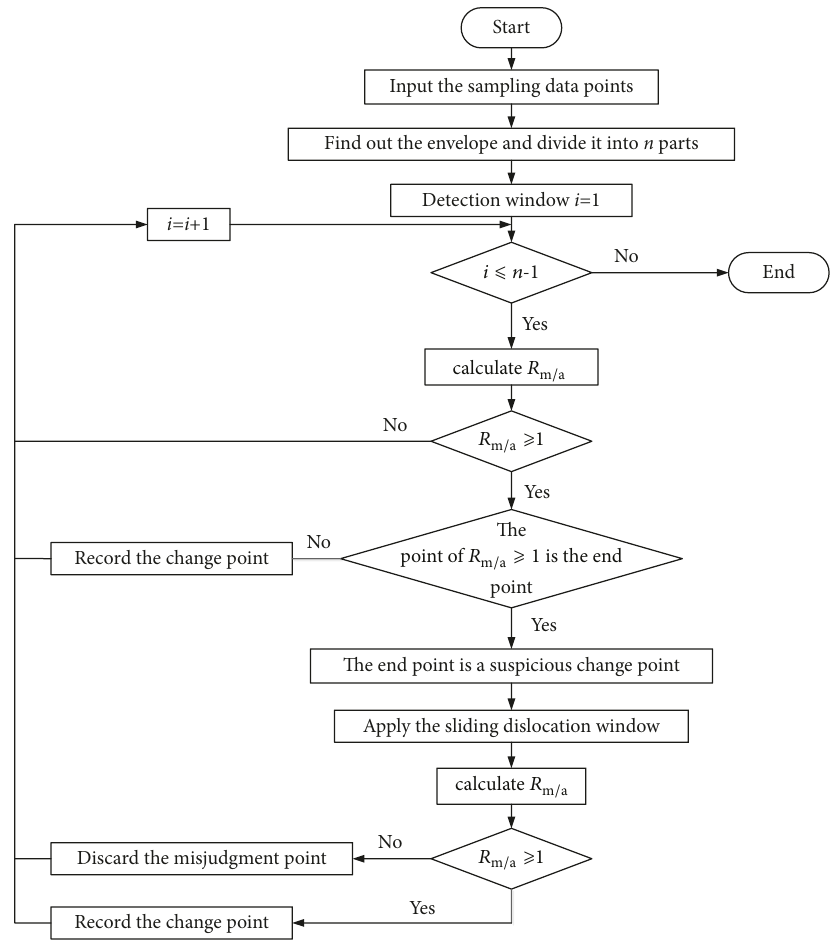
Figure 2: The flow chart of the sliding dislocation window method.